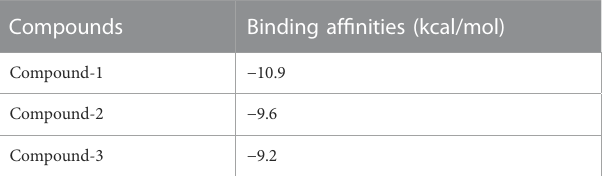
TABLE 5 The binding af fi nities (kcal/mol) of top-ranked 3 compounds against P53. Compounds